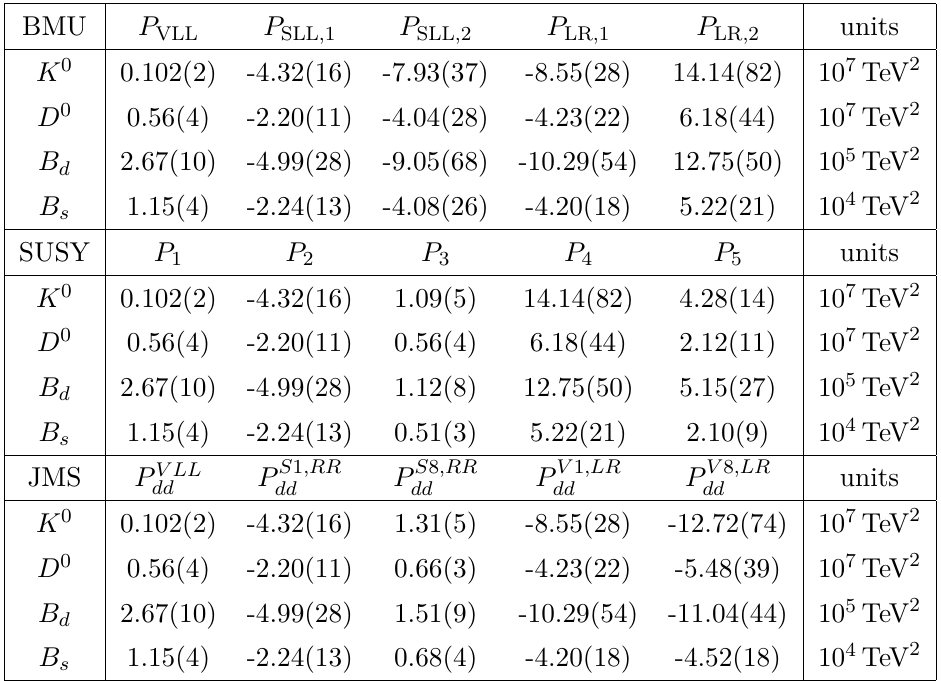
Table 3 . The values of the coefficients P ij µ ew ) entering the LEFT master formula (2.15) at a ( µ ew = 160 GeV in the BMU, SUSY and JMS bases, using as input the MS-NDR matrix elements at the low-energy scale µ had from table 2. The shown uncertainties are due to the either matrix elements or the bag factors and their corresponding chiral enhancement